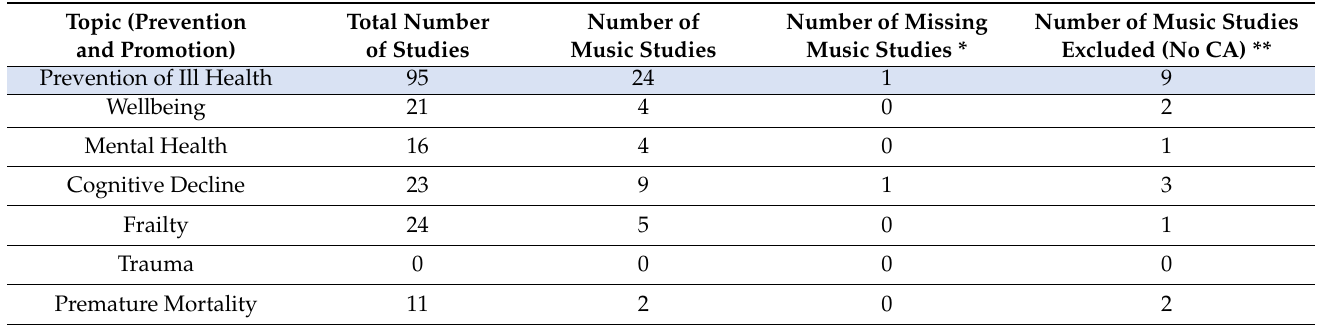
Table 1. Summary of results from Phase 1 Topic: Prevention and